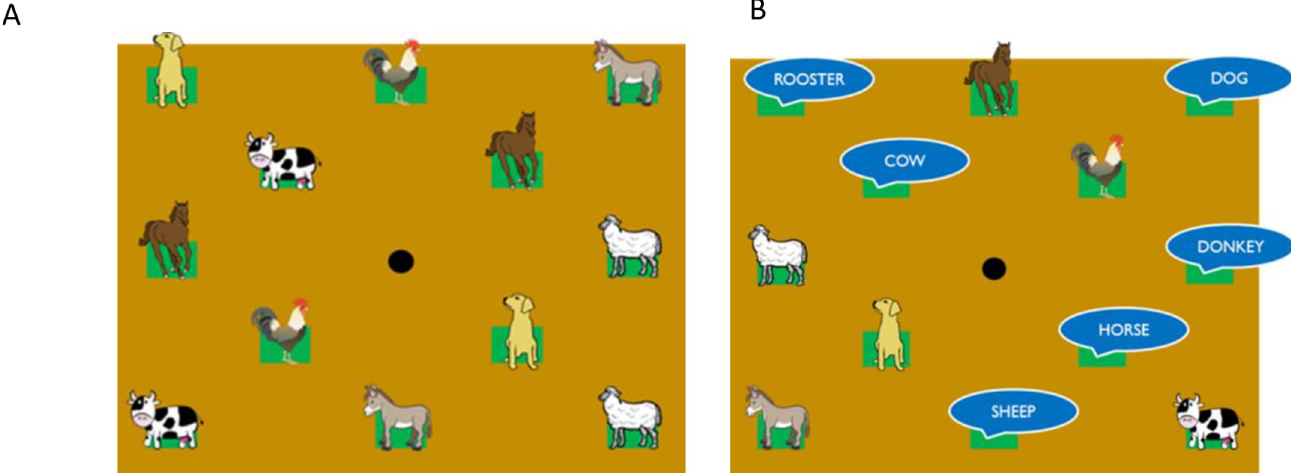
Fig 5. Experimental conditions. A) In the call-call condition, we asked the child to a couple animal calls. B) In the call-name condition, the animal call and the name of the animal had to be